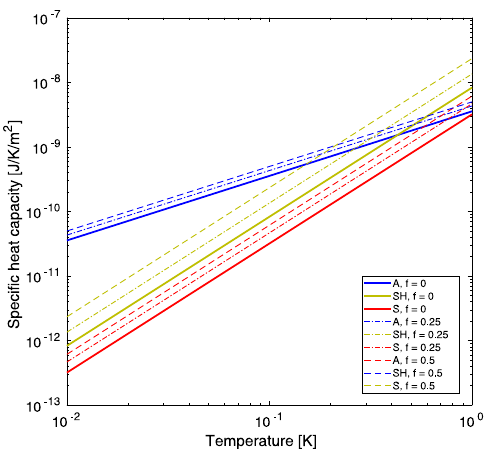
Fig. 5 Modal contributions (A, S, and SH) to the area-speci fi c heat capacity of the holey SiN PnC metaplate. Heat capacity is plotted vs. T , using Eq. (9). Three different fi lling factors f = 0, 0.25, 0.5 are shown, and isotropic SiN parameters E = 250 GPa, ρ = 3100 kg/m 3 , ν = 0.23 and a plate thickness d = 50 nm were